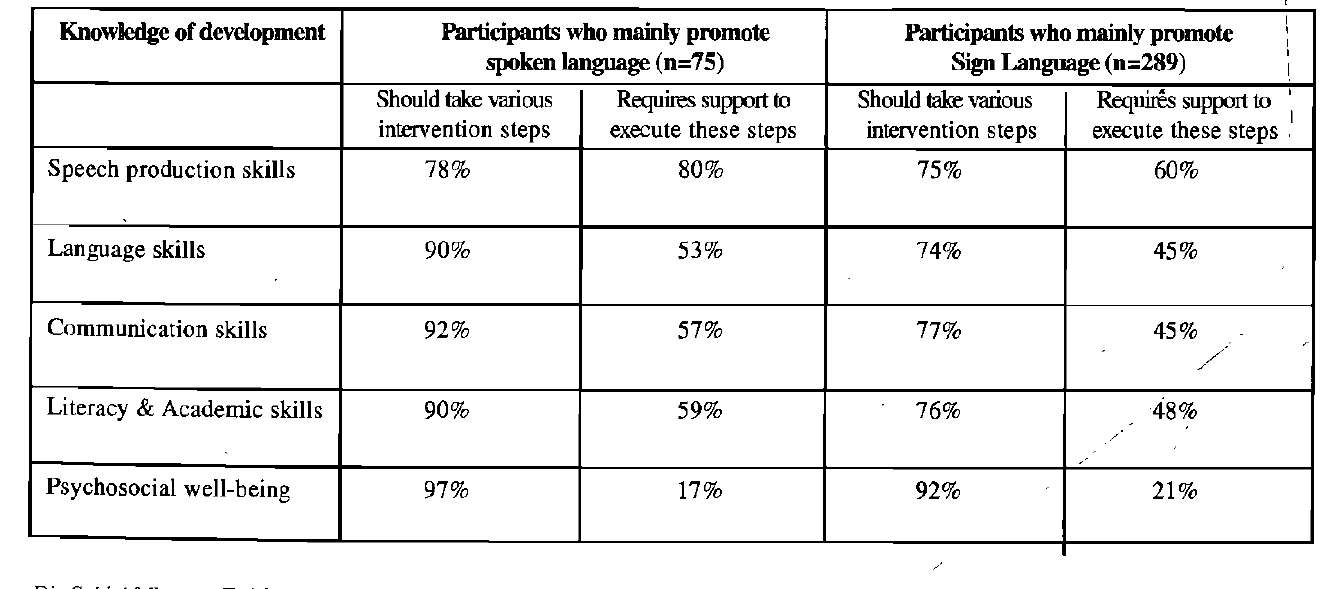
Table 3: Audiological and educational management of the child with hearing